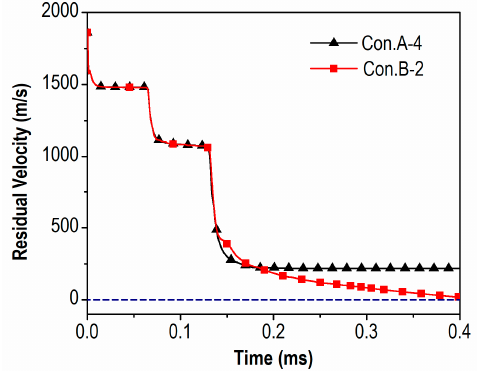
Figure 13. Projectile residual velocity versus time.